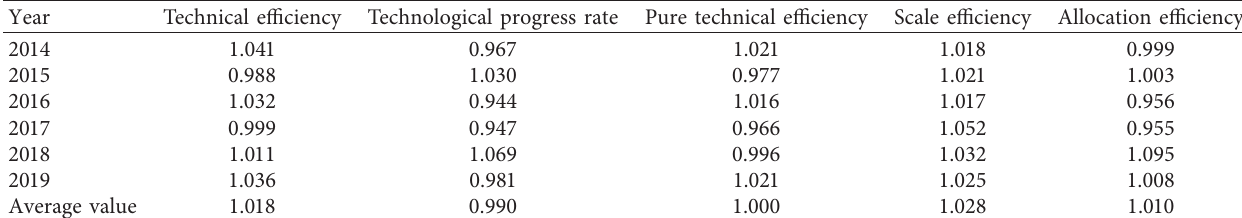
Table 1: Average allocation efficiency of our country’s fiscal R&D resources.